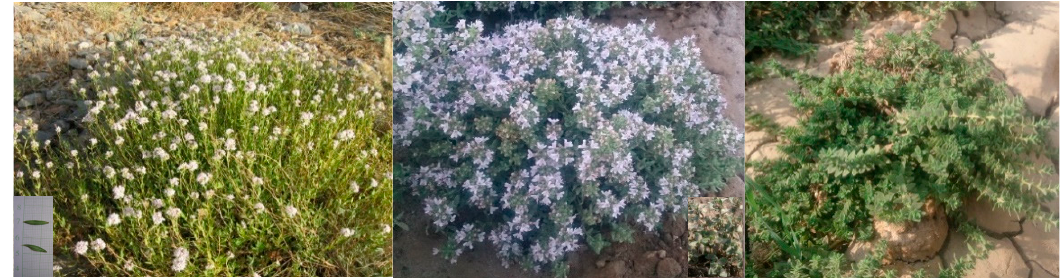
Figure 1. Flowering plants of Thymus daenensis ( left panel ) and T. fedtschenkoi ( middle panel ). The rosette form of the latter species is also provided ( right panel ).